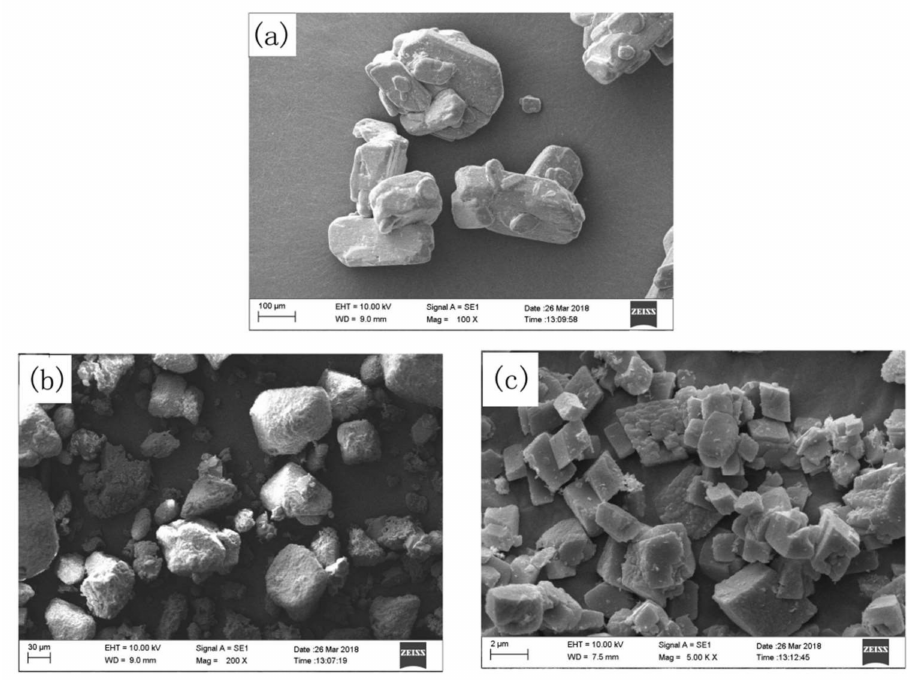
Figure 1. SEM photographs of ( a ) sodium tetraborate decahydrate, ( b ) ammonium pentaborate, and ( c ) zinc